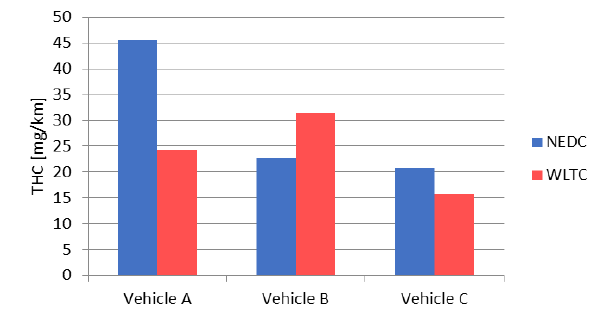
Fig. 14. Hydrocarbons emissions in NEDC and WLTC tests